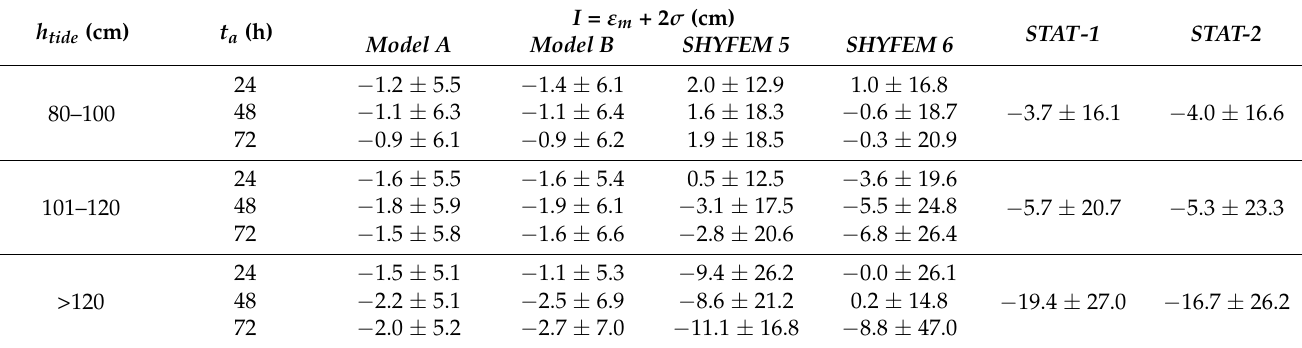
Table 4. Accuracy index grouping the measured tides by height classes: comparison between NARX, SHYFEM, and statistical